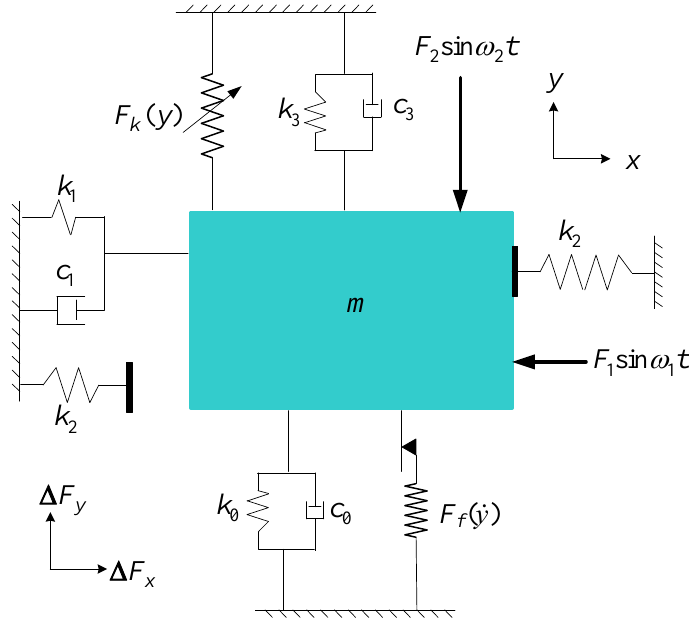
Figure 10. Vertical–horizontal coupling vibration model of hot rolling mill rolls under multi-piecewise nonlinear constraints.